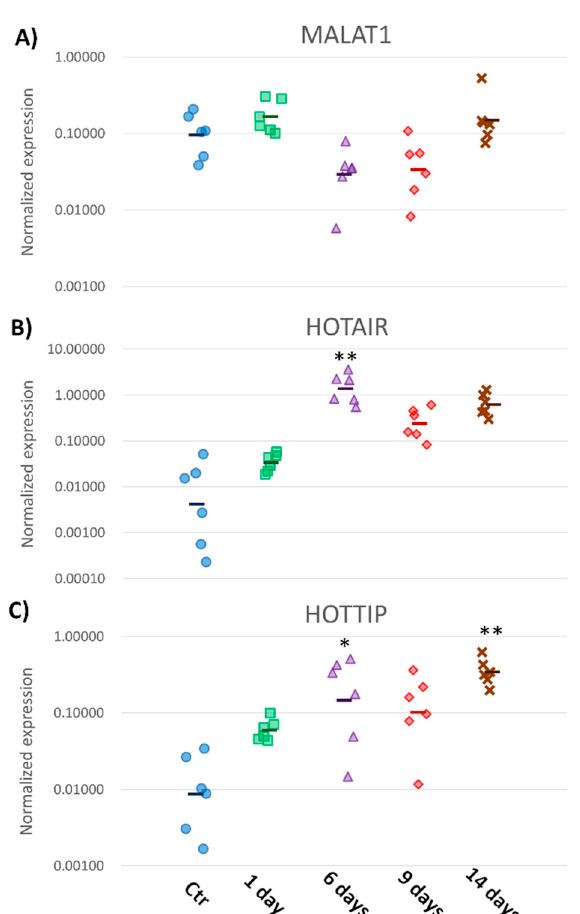
Figure 7. Expression of putative metastasis-associated-in-lung-adenocarcinoma transcript-1 (MALAT1) ( A ), HOX transcript antisense RNA (HOTAIR) ( B ) and HOXA transcript at the distal tip (HOTTIP) ( C ) in whitefish liver after 1, 6, 9 and 14 days of MC-LR exposure quantified using Real-Time polymerase chain reaction (RT-PCR). * p < 0.05; ** p < 0.01. Ctr—control, unchallenged group. Points represent individual fish in respective experimental group.